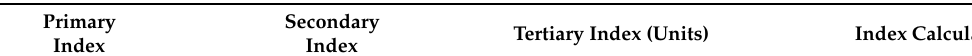
Table 1. Index system of the county sustainable development